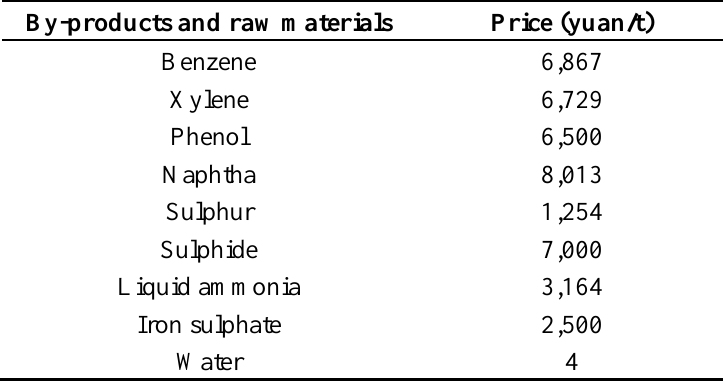
Table 3. Prices of some products and raw materials in